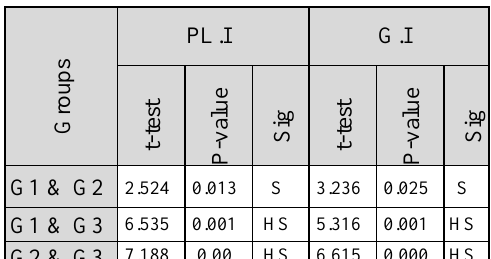
Table (2): Inter group comparison of mean of plaque and gingival indices with significant difference between